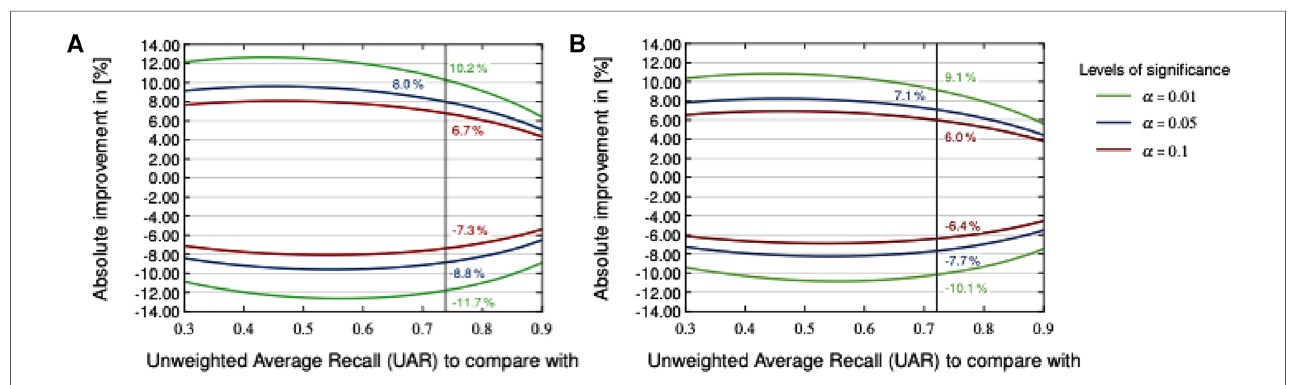
FIGURE 4 Two-sided signi fi cance test on the COVID-19 Cough ( A ) and Speech ( B ) test sets with various levels of signi fi cance according to a two-sided Z -test.